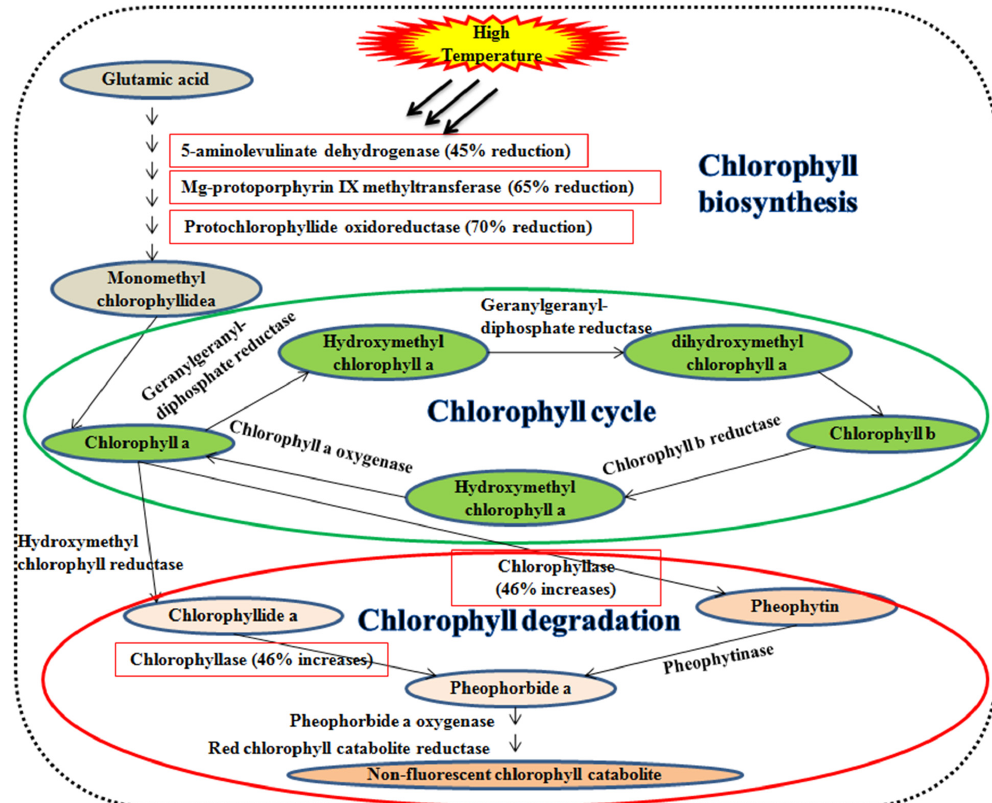
Figure 2. Impact on the high temperature of leaf senescence. Enzymes associated with chlorophyll synthesis viz., 5-ami- nolevulinate dehydrogenase, mg-protoporphyrin IX methyltransferase, and protochlorophyllide oxidoreductase, whereas chlorophyllase is responsible for chlorophyll degradation. synthesis viz., 5- aminolevulinate dehydrogenase, mg-protoporphyrin IX methyltransferase, and